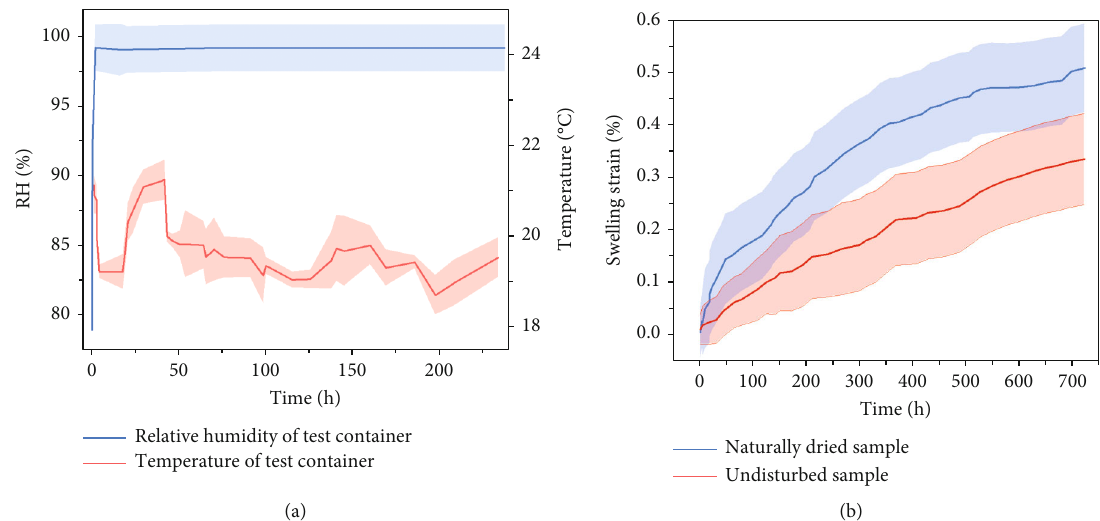
Figure 10: Swelling characteristics of mudstone under controlled humidity: (a) relative humidity and temperature in the test container and (b) deformation changes with time.